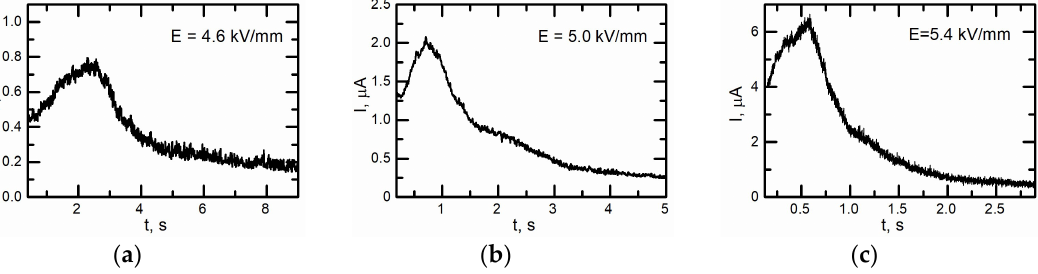
Figure 4. The switching currents measured during the polarization reversal with artificial dielectric layer. Field: ( a ) 4.6 kV/mm; ( b ) 5.0 kV/mm; ( c ) 5.4 kV/mm.